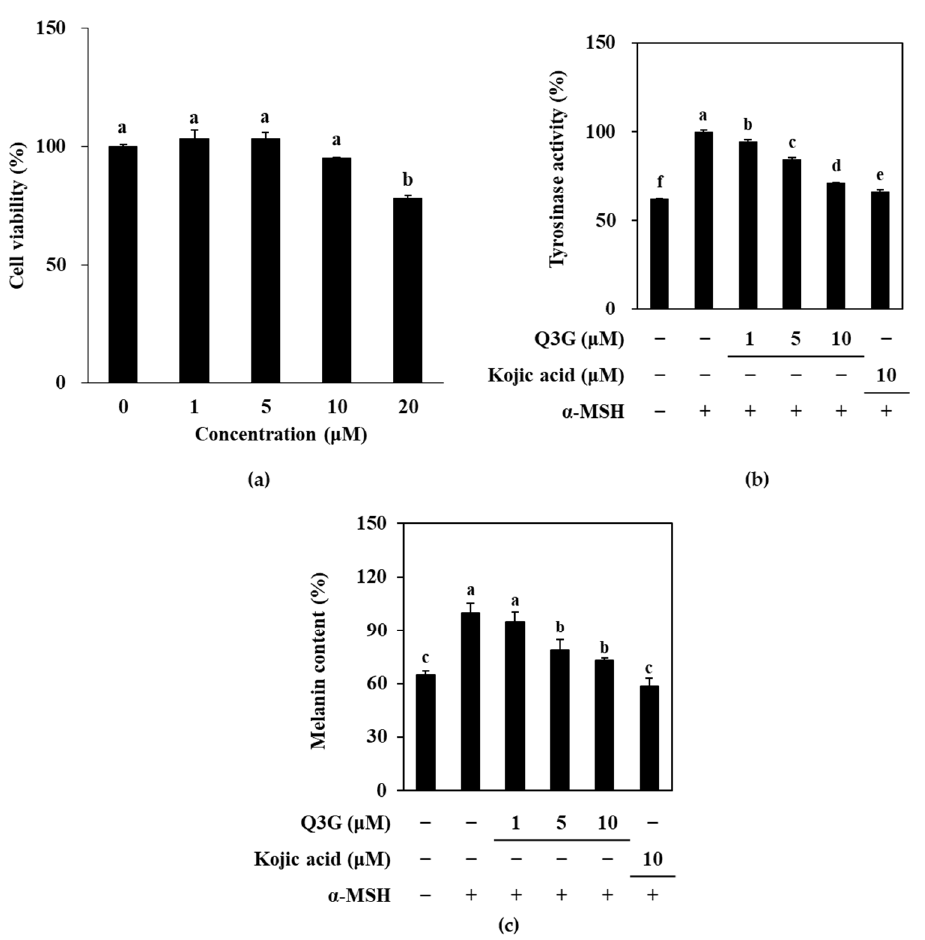
Figure 1. Effect of Q3G on active tyrosinase and melanin content of α -MSH-stimulated B16F10 melanoma cells. ( a ) Cells were treated with Q3G for 24 h prior to MTT assay. Viability of the cells was given as relative percentage of untreated (0 µ M) group. ( b ) Tyrosinase activity was measured via ability of cell lysates to hydroxylate L-DOPA and was given as relative percentage of α -MSH-stimulated untreated group. ( c ) Total melanin contents were measured via ELISA and were given as relative percentage of α -MSH-stimulated untreated group. Kojic acid was used as positive control. a–f groups with different superscript letters are significantly different, whereas same superscript letters mean no significant difference according to Duncan’s multiple range post-hoc test ( p < 0.05).